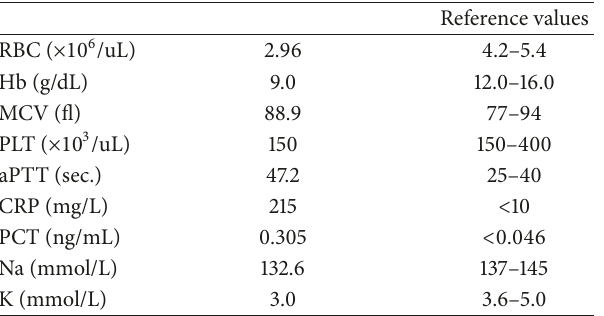
Table 1: Biochemical data nine days after hip